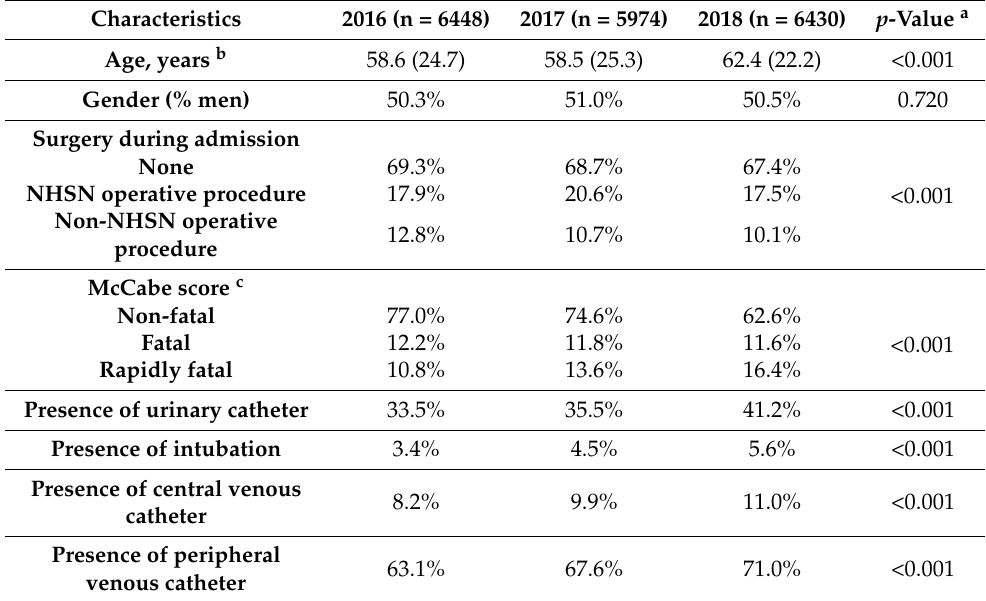
Table 1. Characteristics of patients by year of the Point Prevalence